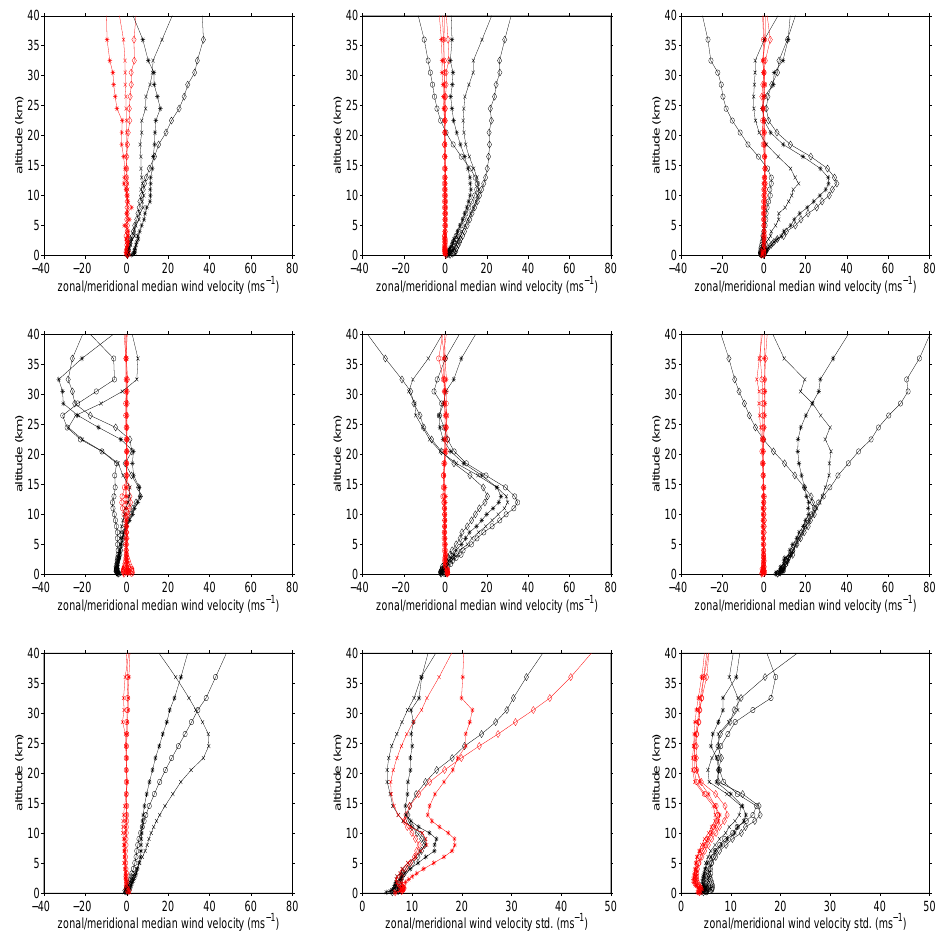
Fig. 9. ECMWF model wind statistics along CALIPSO orbits. Median zonal (black) and meridional (red) wind profiles (ms − 1 ) for the following climate zones: NH pole, NH mid-latitudes, NH Subtropics (top row from left to right), Tropics, SH subtropics, SH mid-latitudes (middle row) and SH pole (bottom row, left panel). In addition, the standard deviation from the mean wind for the NH polar region (bottom, middle) and Tropics (bottom, right). The symbols denote the various months: January (diamond), April (star), August (circle) and October